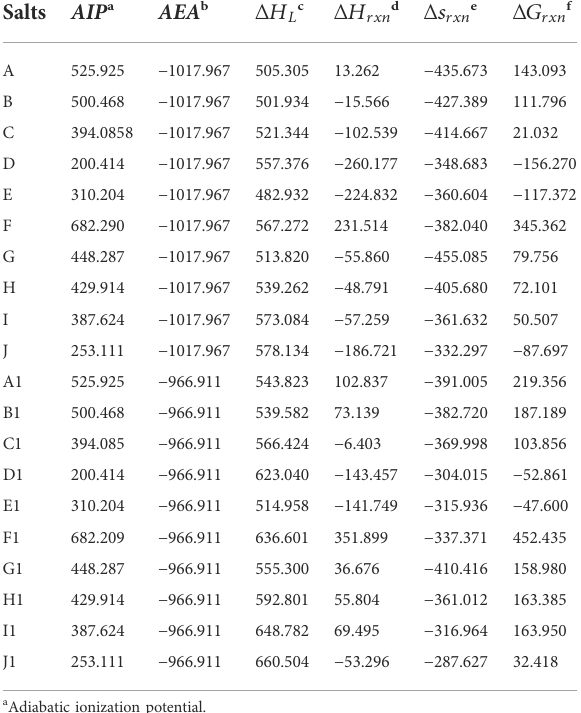
TABLE 5 Calculated adiabatic ionization potential ( AIP ), adiabatic electron af fi nity ( AEA ), lattice energy ( Δ H L ), reaction enthalpy change ( Δ H rxn ), entropy change ( Δ s rxn ) and Gibbs free energy change of formation ( Δ G rxn ) for N 5 + salts and O 2 + salts.